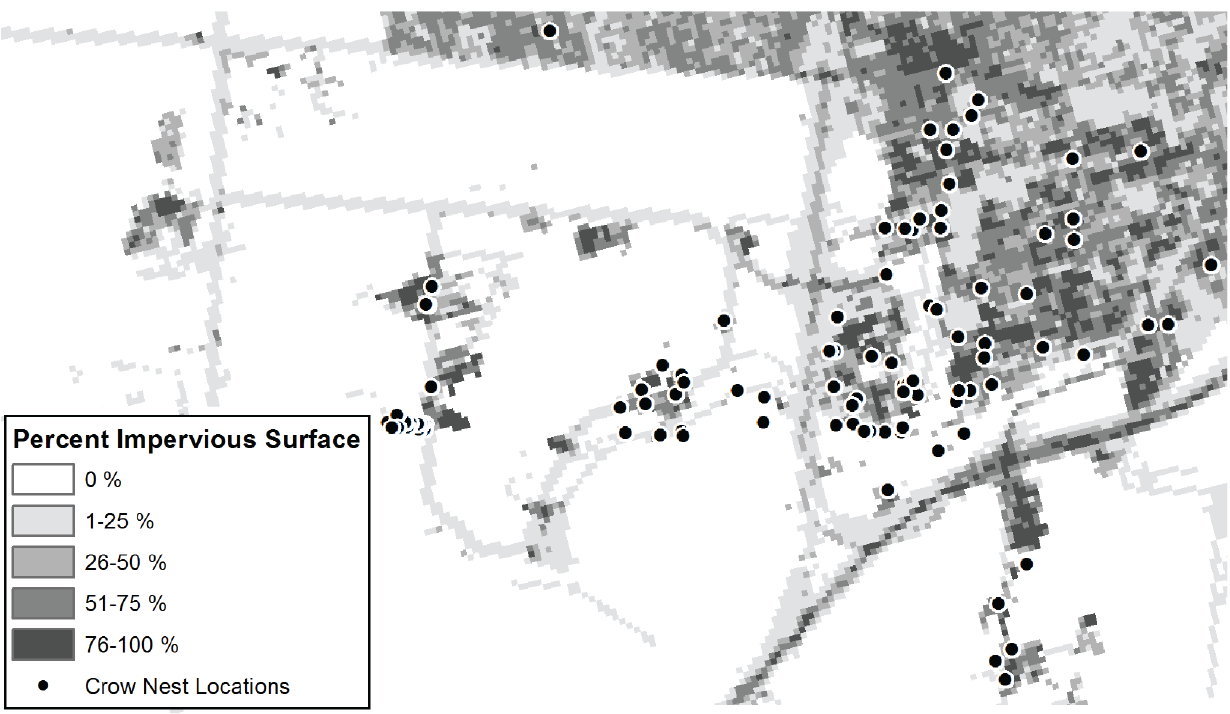
Figure 2. Percentage of each type of anthropogenic material in nests. Examples from nests are shown to right ( n =678 total items; 54 nests).